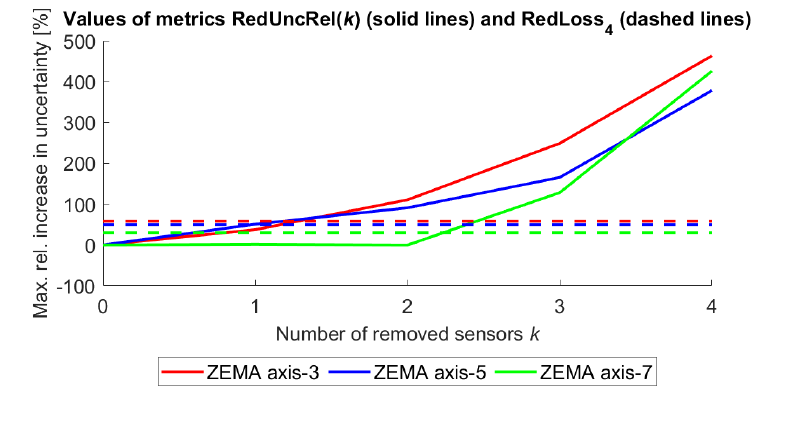
Figure 9. Relative uncertainty increase and redundancy loss values for condition monitoring of EMCs in ZeMA testbed when using 5 sensors and taking out 0 to 4